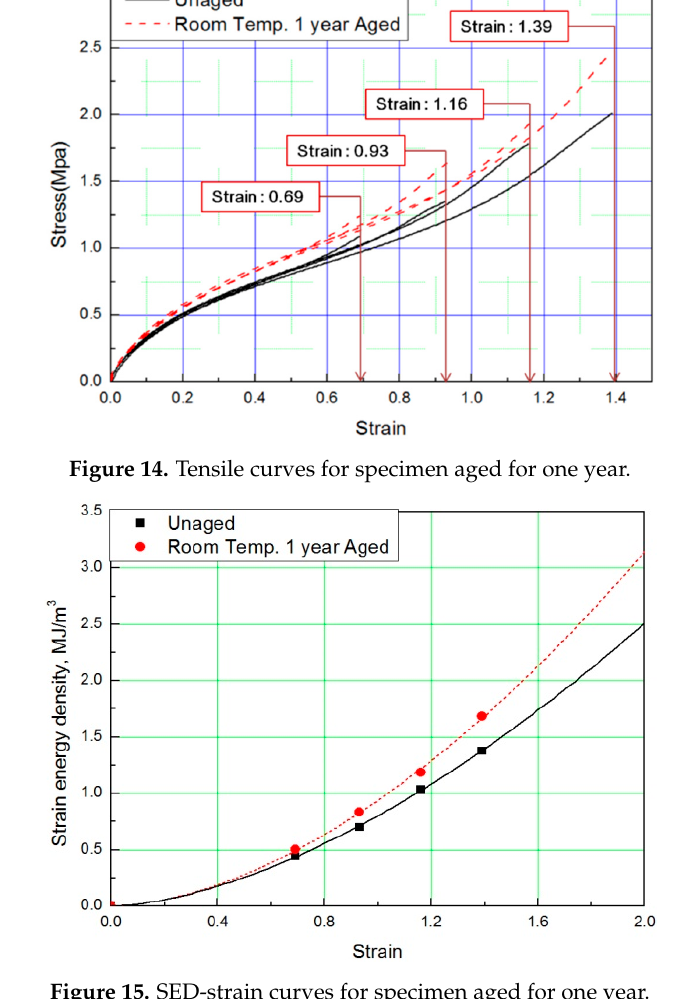
Figure 15. SED-strain curves for specimen aged for one year. Table 6. Results of degradation conversion.